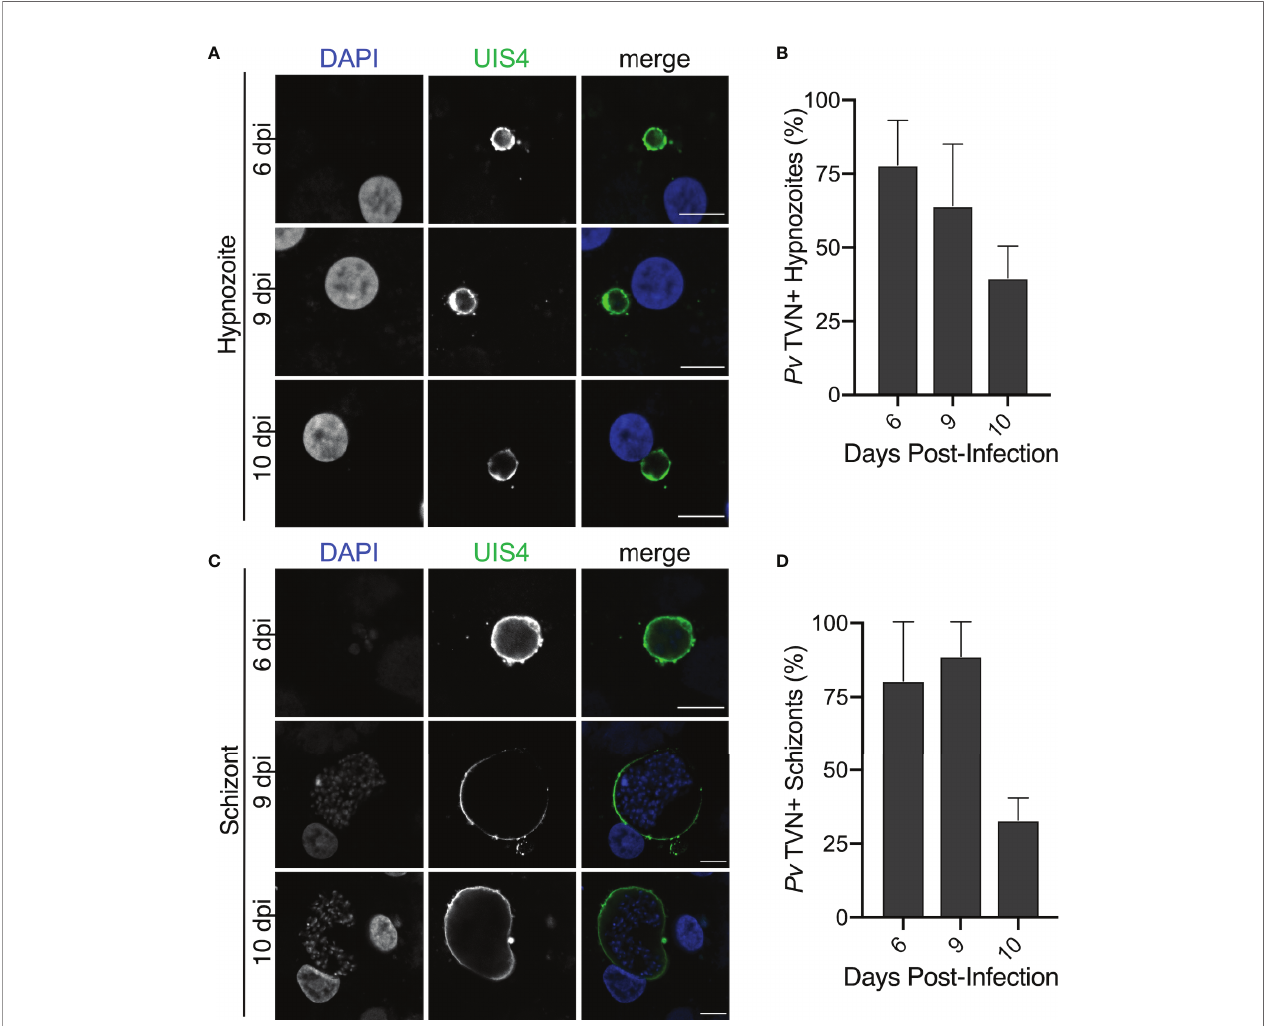
FIGURE 4 | TVN features in P. vivax hypnozoites and schizonts. (A) Representative confocal images of P. vivax TVN+ hypnozoites in PHH at 6, 9, and 10 dpi. Host and parasite nuclei stained with DAPI (blue) and parasite PVM stained with anti- Pv UIS4 (green). Scale bar is 10 µm. (B) Percent of TVN+ hypnozoites at 6, 9, and 10 dpi. Data reported as mean ± SEM. (C) Confocal images of TVN+ schizonts in PHH at 6, 9, and 10 dpi. Host and parasite nuclei stain with DAPI (blue) and Plasmodium PVM stained with anti- Pv UIS4 (green). Scale bar is 10 µm. (D) Percent of TVN+ schizonts at 6, 9, and 10 dpi. Data reported as mean ± SEM. (A – D) >50 EEFs each day, n=2 biological